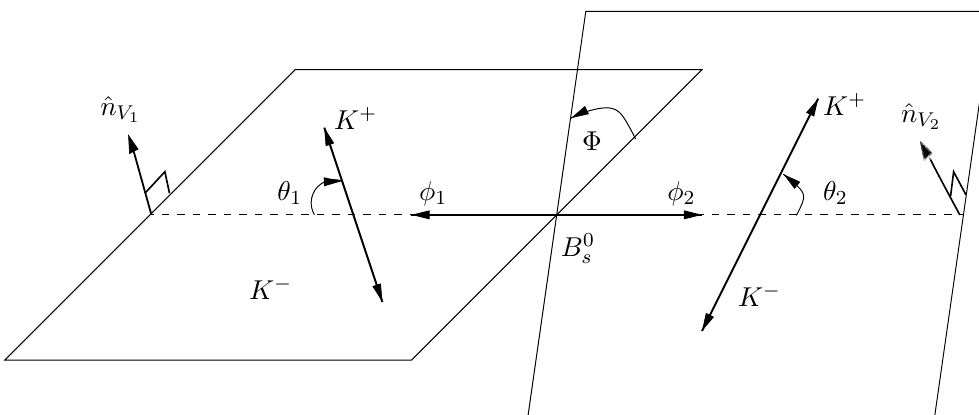
Figure 2 . Decay angles for the B 0 in the (cid:30) 1 ; 2 meson rest frame and the (cid:30) 1 ; 2 momentum in the B 0 two (cid:30) meson decay planes and ^ n V